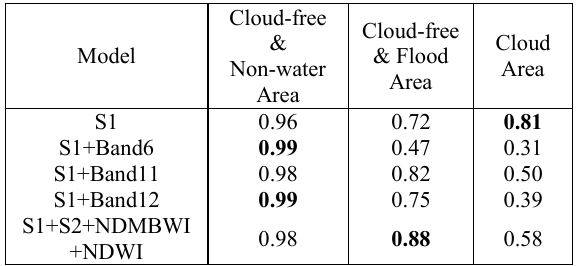
Table 2 . Recall scores of different models.